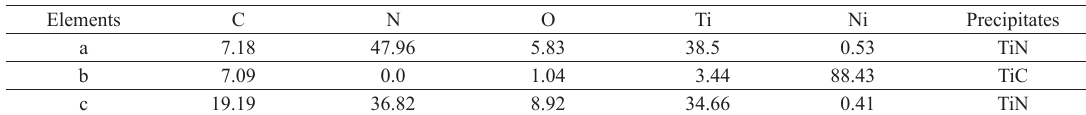
Table 6. Chemical constituents of precipitated phases(at. %).